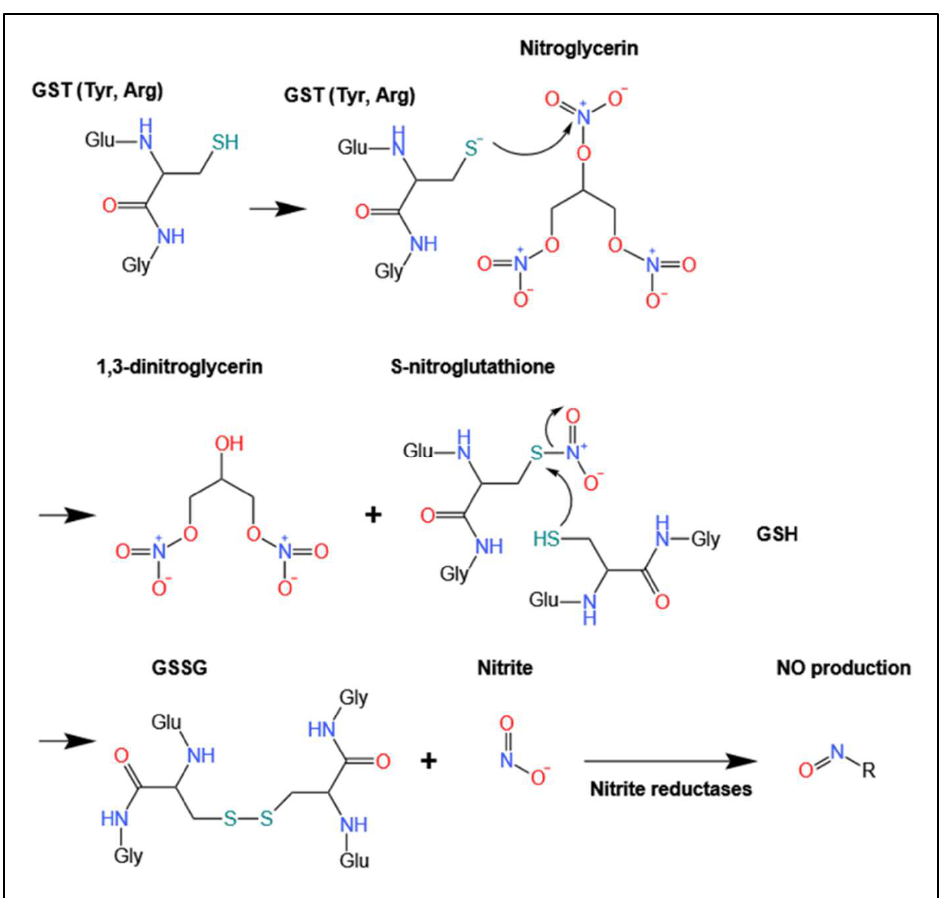
Figure 3. Schematic of the proposed mechanism for the biotransformation of nitroglycerin to form GSSG and nitrate via a mechanism mediated by the binding of GSH to GST. This scheme has been modified from [56].